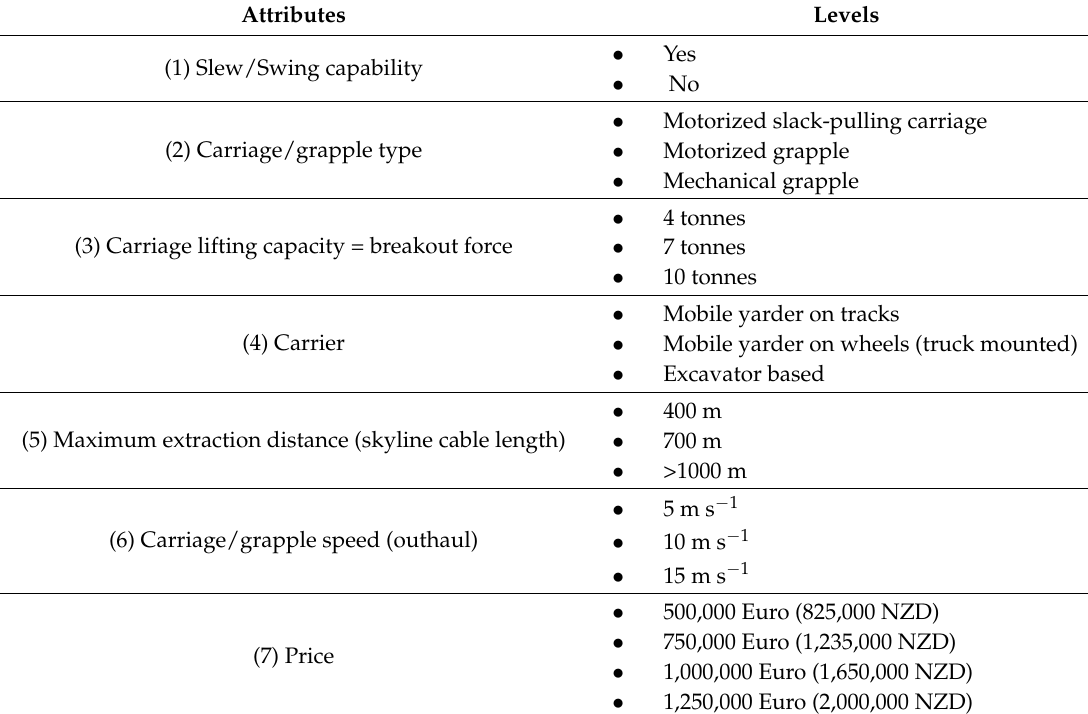
Table 1. Attributes and levels for the design of a new